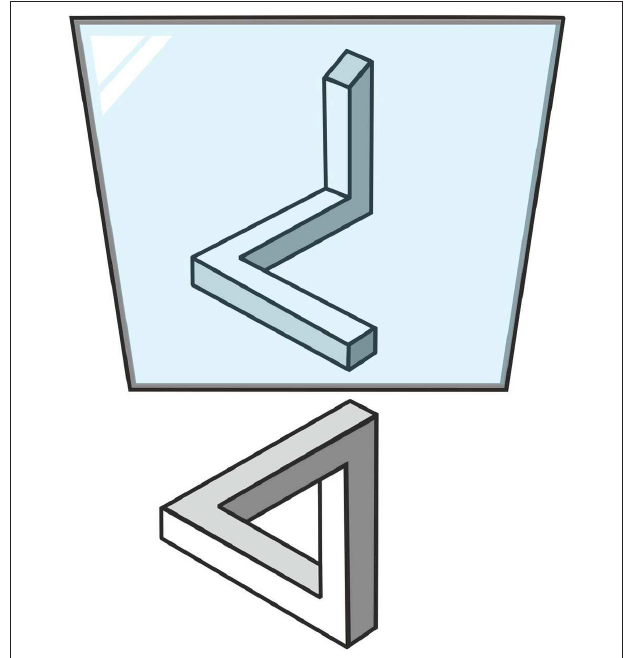
FIGURE 2 | Penrose’s “impossible” triangle, placed in front of a mirror, turns out to be not so